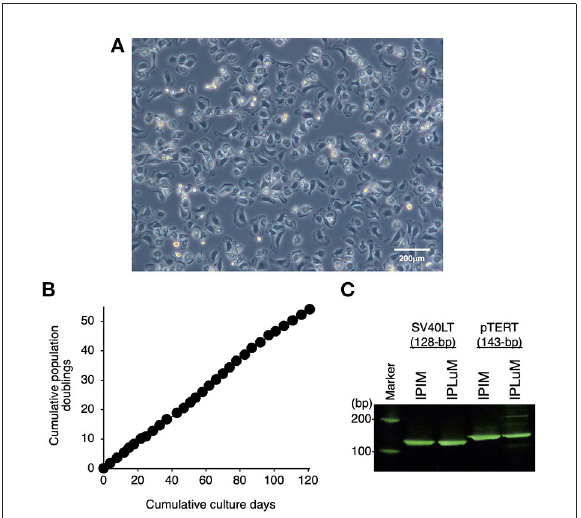
FIGURE1 Establishment of the IPLuM cell line. The morphology of IPLuM was examined under a phase-contrast microscope (A) . The cumulative population doublings of the IPLuM were plotted against the duration of the culture period (in days) (B) . The PCR products generated from the SV40LT (128 bp) and pTERT (143 bp) genes were detected by genomic DNA PCR analysis of IPIM and IPLuM (C)